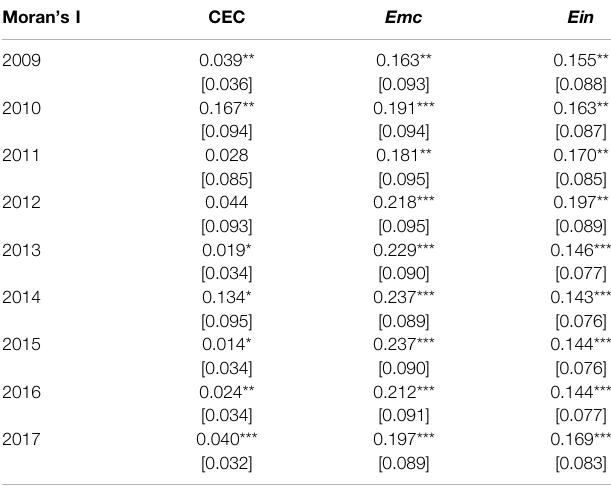
TABLE 5 | Moran ’ s I statistics of CEC, CO 2 emissions and energy intensity from 2009 to 2017. Moran ’ s